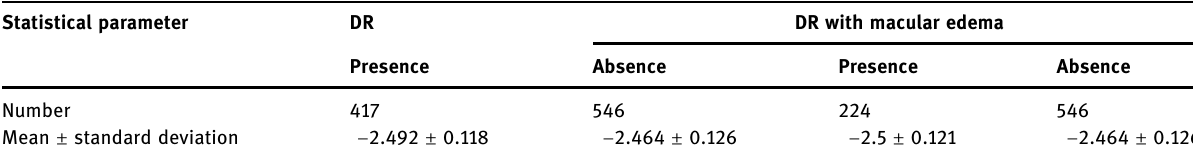
Table 5: Standard deviation and mean for DR and DR with macular edema in MESSIDOR Statistical parameter